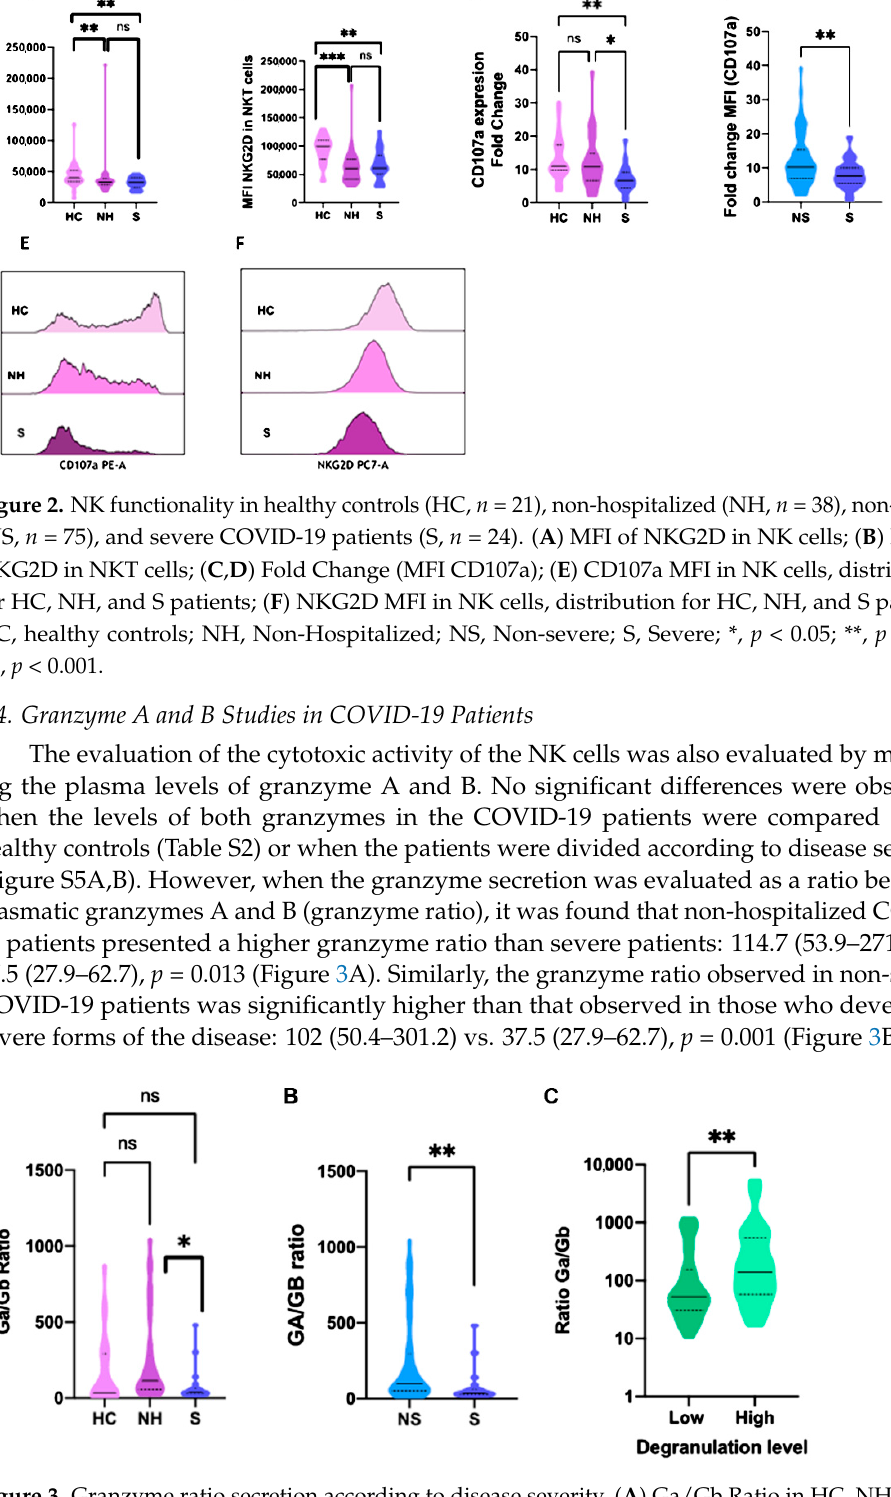
Figure 3. Granzyme ratio secretion according to disease severity. ( A ) Ga/Gb Ratio in HC, NH, and COVID-19 patients; ( B ) Ga/Gb Ratio in NS and S COVID-19 patients; ( C ) Ga/Gb Ratio according to degranulation activity. HC, Healthy controls; NH, Non-hospitalized; NS, Non-severe; S, Severe. Low, CD107a expression Fold Change <9%; High, CD107a expression Fold Change >9%; *, p < 0.05; **, p < 0.01.